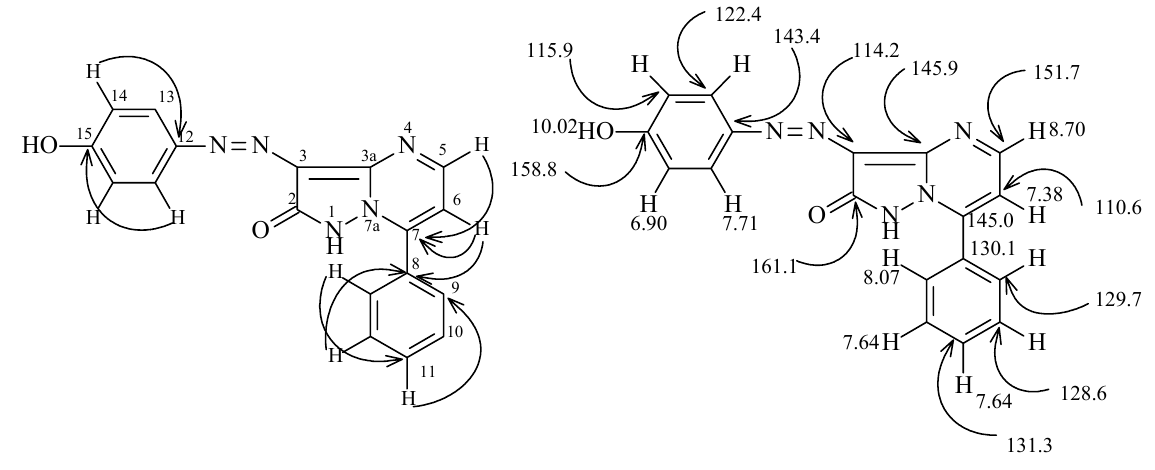
Figure 3. 1 H- and 13 C-NMR of compound 15a